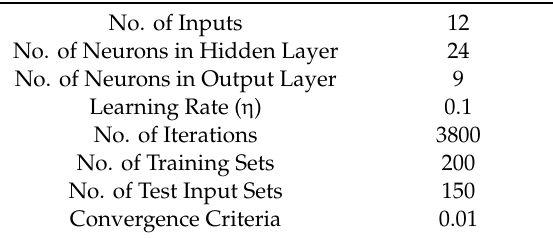
Table 1. Specifications of FFT—ANN-Lab VIEW Approach.